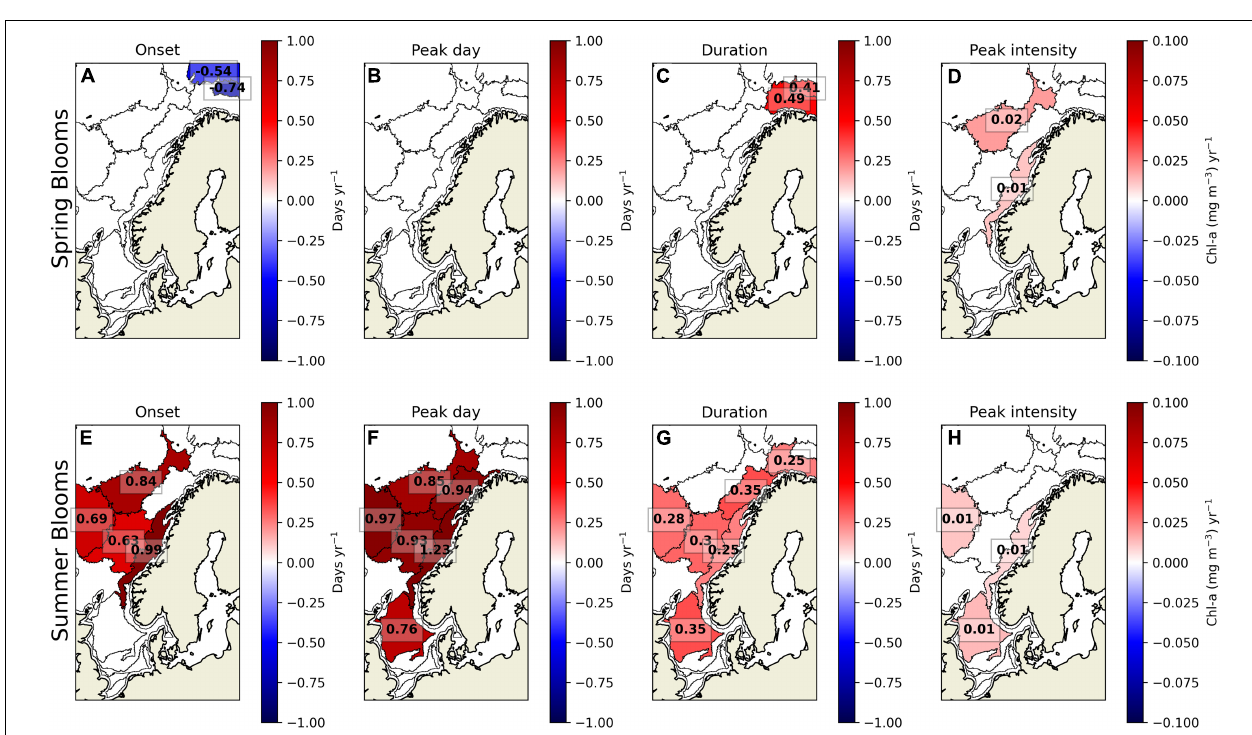
FIGURE 5 | The trends of spring and summer blooms phenology from 2000 to 2020. The subplots are the spring bloom (A) onset, (B) peak day, (C) duration, and (D) intensity; the summer blooms (E) onset, (F) peak day, (G) duration, and (H) intensity. Sub-regions where trends are insignificant ( α > 0.05) are masked in white.